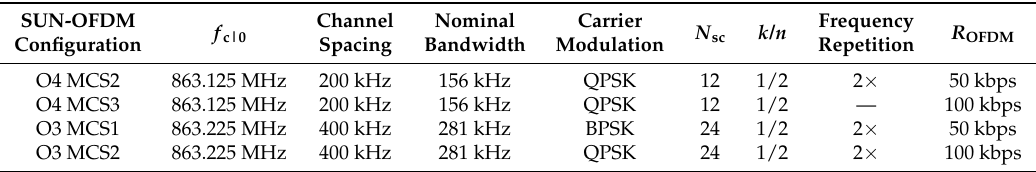
Table 2. Properties of selected IEEE 802.15.4 Smart Utility Network (SUN) Orthogonal Frequency Division Multiplexing (OFDM) physical layer (PHY)